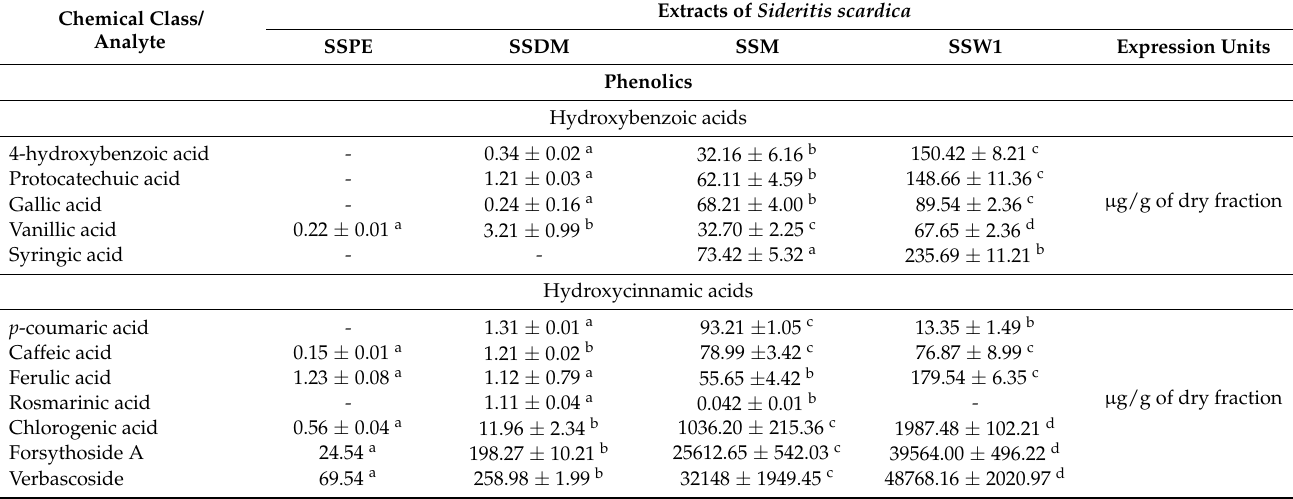
Table 1. Quantitative information illustrating the phytochemical contents of the four isolated (petroleum—SSPE; dichloromethane—SSDM; methanolic—SSM; initial aqueous—SSW1) extracts of S. scardica. The results represent the means ± SD of six separate studies. Tukey’s test ( p < 0.05) showed that means and standard deviations (SDs) proceeded by different letters in the same row importantly vary from one